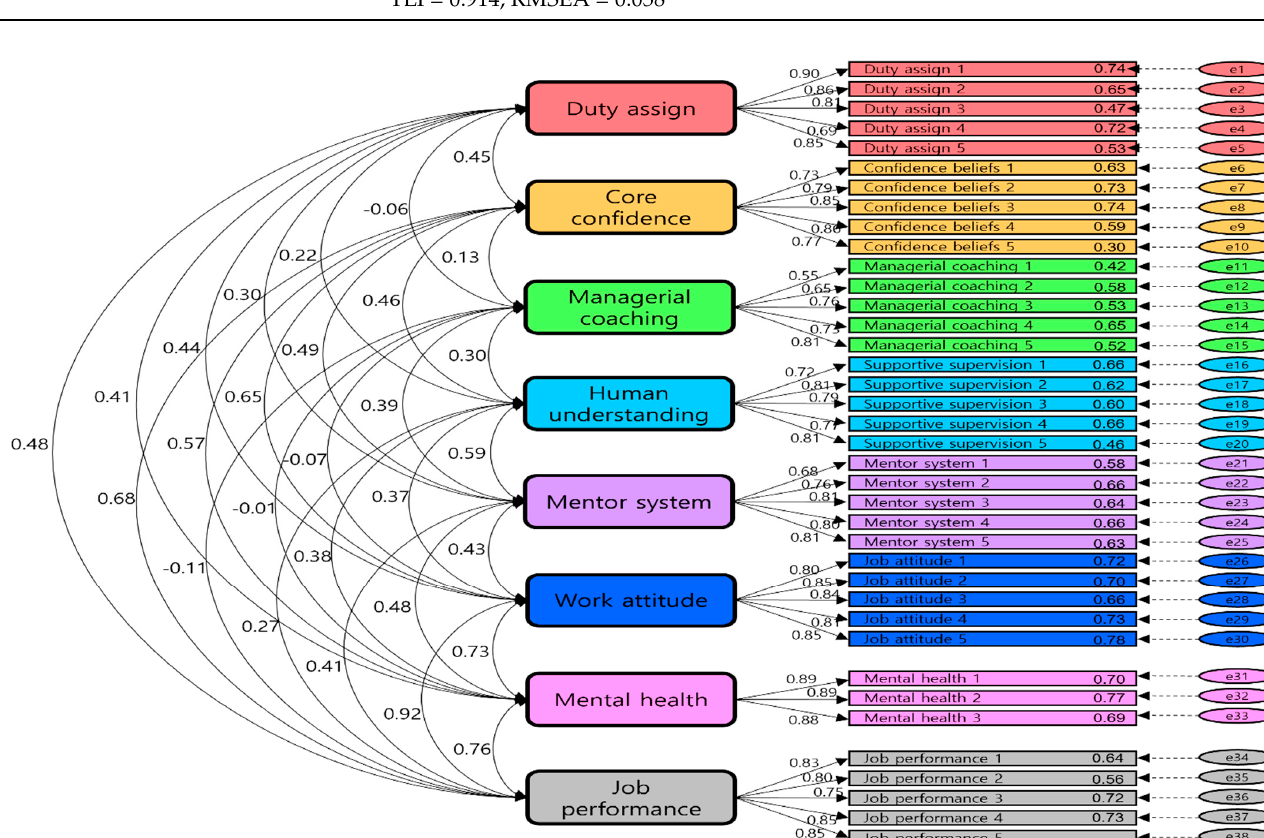
Figure 2. Confirmative Factor Analysis